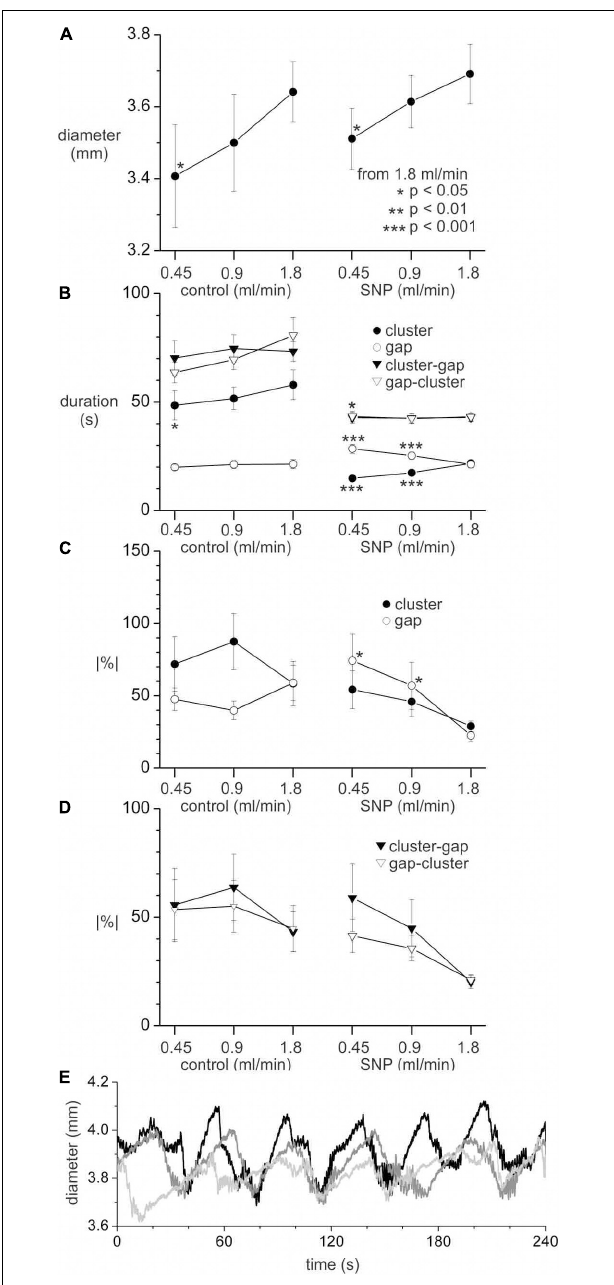
FIGURE 11 | Effect of perfusion rate on distension, clusters and gaps with and without 1 µ M SNP. All values are means ± standard error for data from seven intestines. (A) Mean intestine diameter. (B) Cluster, gap and cycle (cluster-gap or gap-cluster) durations. (C) Absolute percentage change in duration from cluster to cluster or gap to gap. (D) Absolute percentage change in duration from cycle to cycle. Statistical comparisons made to 1.8 ml/min perfusion rate in control and SNP groups, by paired t -test (A) or Mann Whitney rank sum z -test (B–D) . The p scale in panel (A) applies to all graphs. Number of clusters, gaps or cycles for panels (B–D) range from 33 to 94 and are not shown for clarity. (E) Spatially averaged diameter for one intestine in the presence of SNP with a perfusion rate of 1.8 (black), 0.9 (dark gray) and 0.45 (light gray) ml/min. Upward deflections in diameter correspond to gaps and downward deflections to